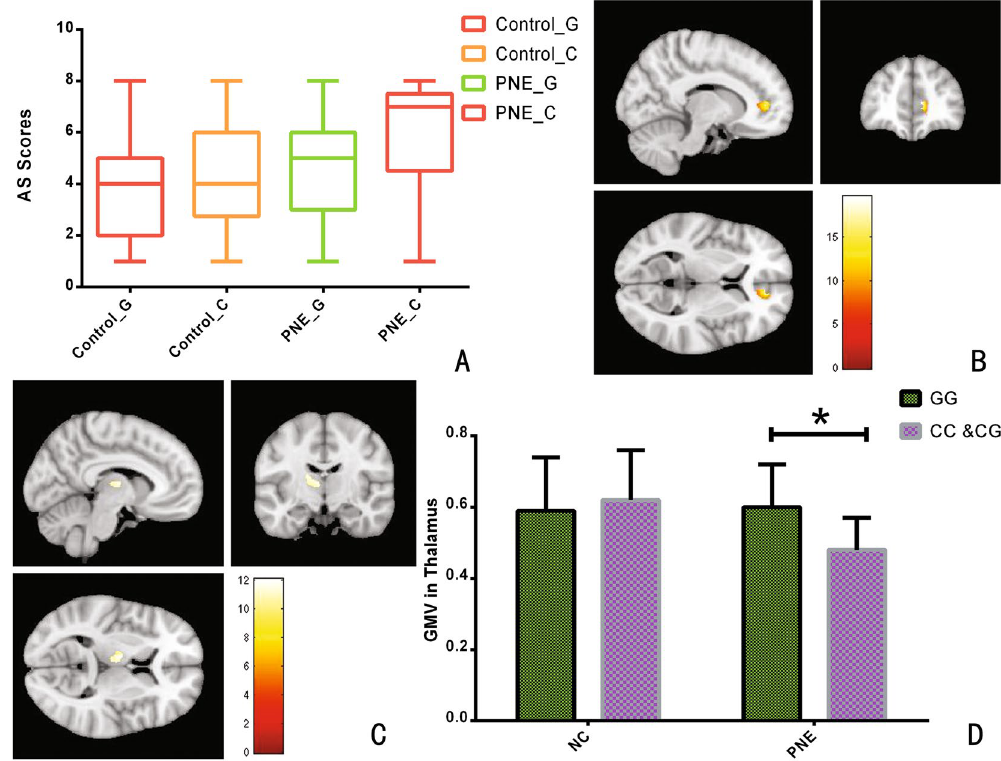
Figure 1. Association between DRD4 − 616 C/G and AS and GMV. ( A ) Comparisons of AS scores in different genotypes and groups. ( B ) Whole-brain thalamic VBM analysis demonstrates a significant main effect of genotype in the pregenual ACC. ( C ) Whole-brain thalamic VBM analysis demonstrates a significant interaction between genotype and group in the thalamus. ( D ) PNE C-allele carriers exhibited a significantly decreased GMV in the pregenual ACC compared to the PNE G-allele